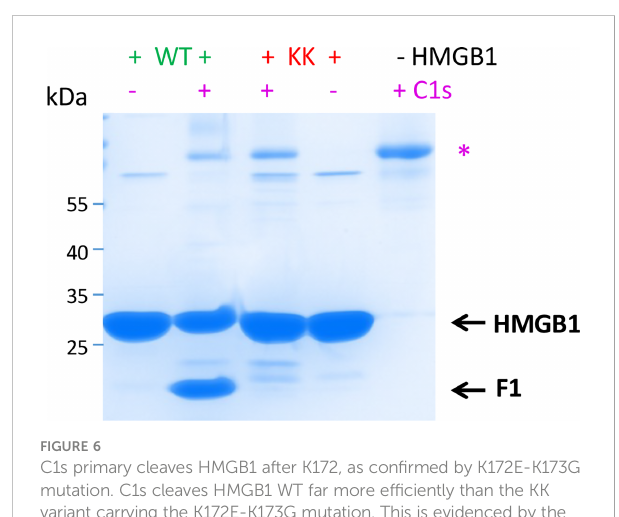
FIGURE 6 C1s primary cleaves HMGB1 after K172, as con fi rmed by K172E-K173G mutation. C1s cleaves HMGB1 WT far more ef fi ciently than the KK variant carrying the K172E-K173G mutation. This is evidenced by the differential level of HMGB1 and primary cleavage product (F1, 1-172). Therefore, C1s primarily cleaves HMGB1 after K172. HMGB1 (6 m g) has been incubated for 100 min at 37°C, without (-) or with 5% (+) rC1s. SDS-PAGE analysis in non-reducing conditions. 2 m g rC1s have been deposited on the right lane for control. * as in Figure